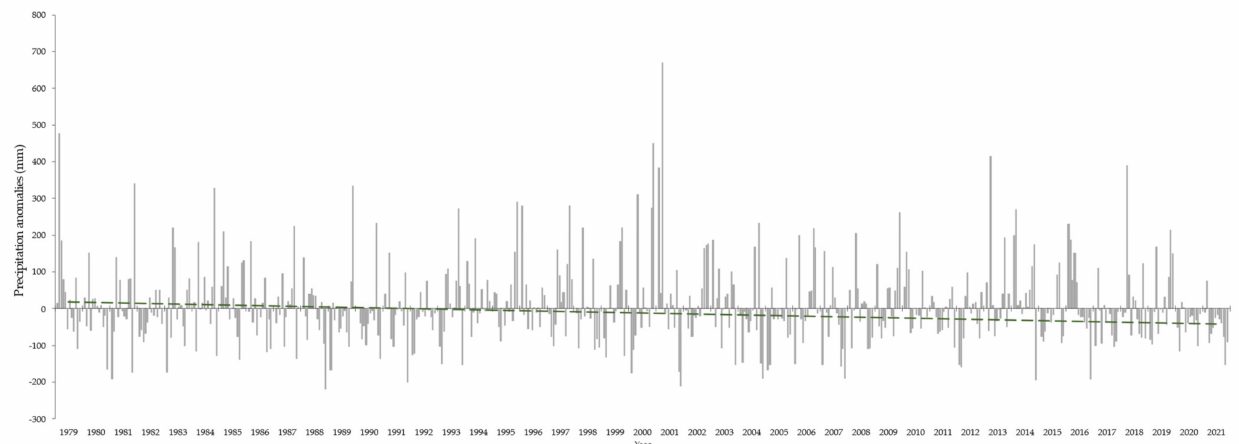
Figure 11. Distribution of rainfall anomalies for each year in the period of 1979–2021.